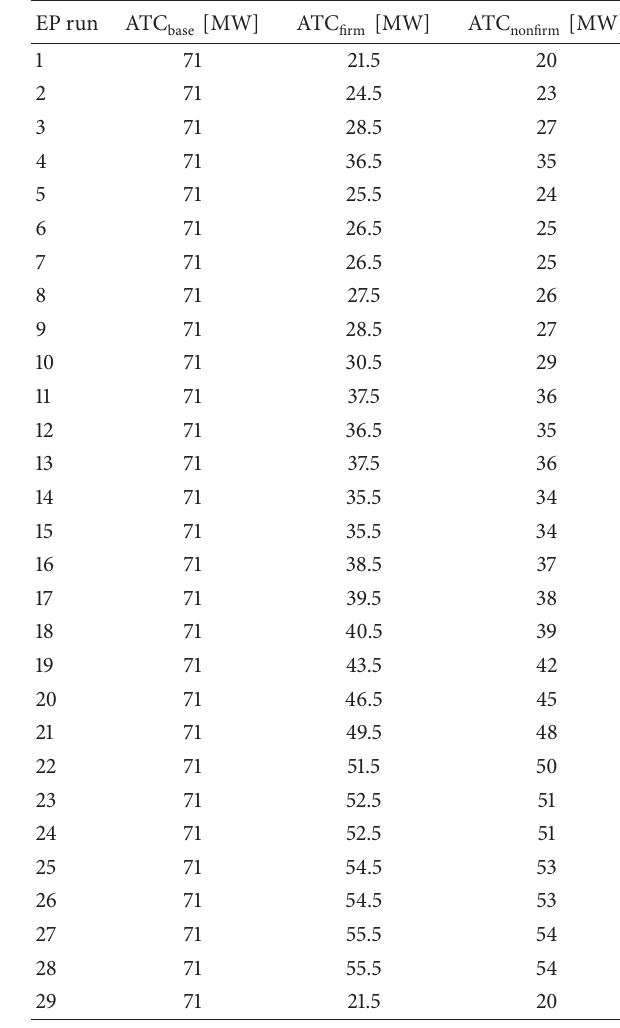
Table 9: Results of ATC from area 2 to area 1. Table 10: Results of ATC from area 3 to area